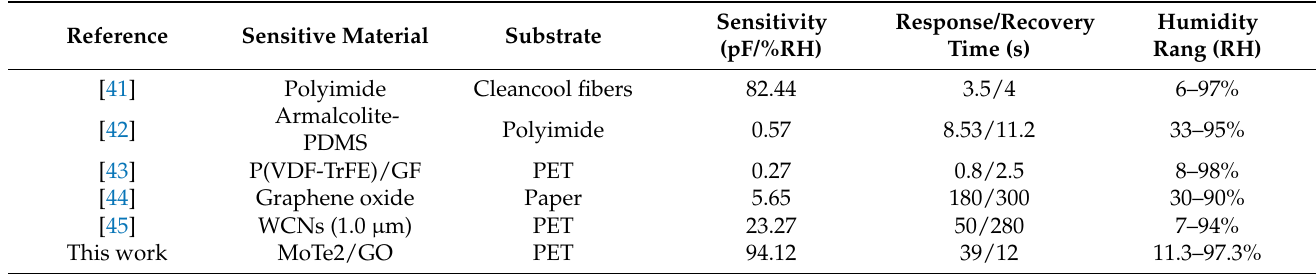
Table 1. Performance comparison of the proposed sensor in this work with the previous published flexible humidity sensors.